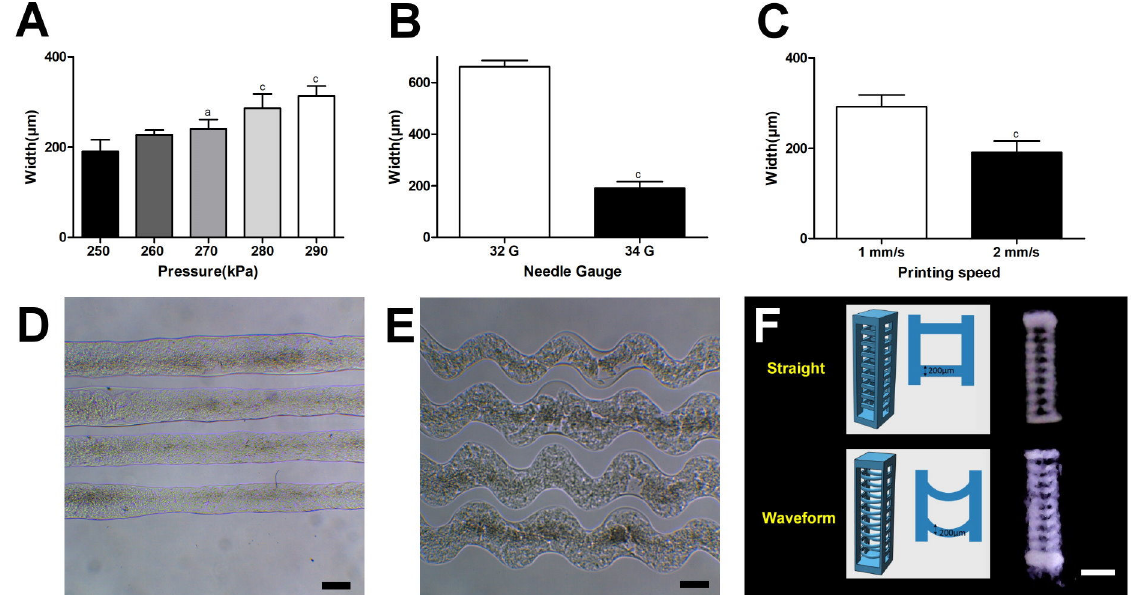
Figure 3. The characterization of the collagen microfibrous scaffold. ( A – C ) The optimization of the bioprinting process by printed line width analysis. ( A ) The printing pressure under the 34 G nozzle and the 2 mm/s speed (significant difference to 250 kPa printing pressure: a = p < 0.05, c = p < 0.001). ( B ) The nozzle diameter under the 250 kPa pressure and the 2 mm/s speed (significant difference: c = p < 0.001). ( C ) The printing speed under the 250 kPa pressure and the 34 G nozzle (significant difference: c = p < 0.001). ( D , E ) The resultant ( D ) straight and ( E ) waveform microfibers under the optimized condition. Scale bar: 200 µ m. ( F ) The designed and resultant waveform microfibrous scaffolds for PDL regeneration. The dimensions of each microfibrous scaffold were designed to be 3 mm high, 1 mm wide, and 0.8 mm thick, and the thickness of the microfiber was designed to be 200 µ m. Scale bar: 1